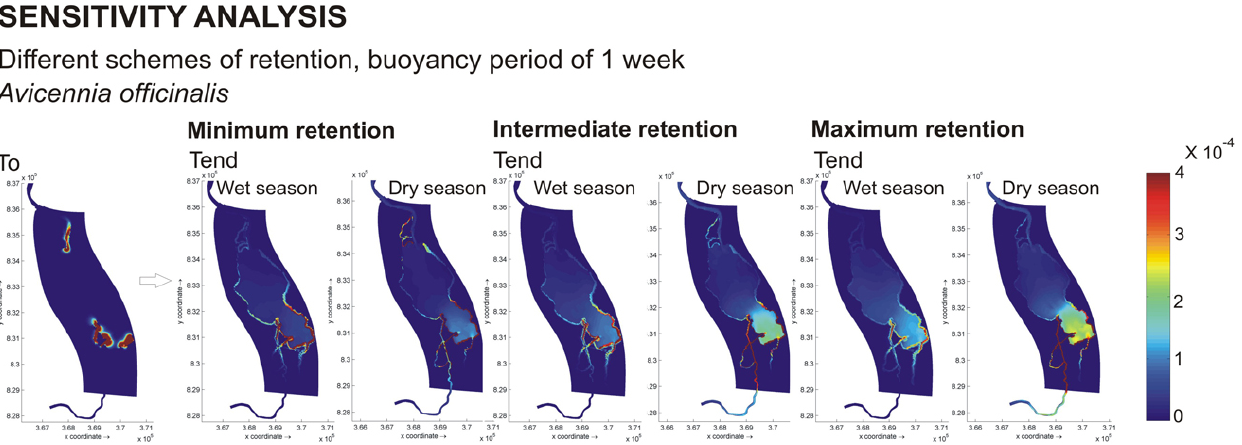
Fig. 4a. Results of the sensitivity analysis: distribution patterns for the species Avicennia officinalis when varying the retention schemes from minimum, intermediate to maximum retention values. Red, yellow and light blue colours indicate a high, medium and low concentration of propagules respectively.